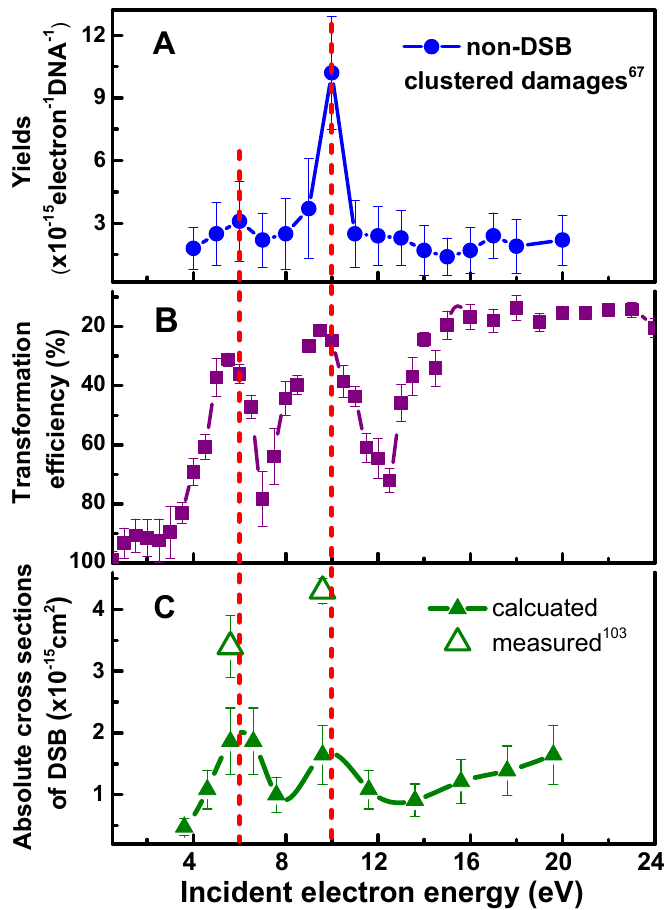
Figure 2. ( A ): Energy dependence of non-DSBs clustered damages [67]. ( B ): Inverted percentage curve that represents the transformation e ffi ciency of E. coli cells. It was produced by irradiating with 0.5–24 eV electrons the pGEM3Zf( − ) plasmid required for survival of the competent cells. ( C ): Absolute cross sections for inducing DSBs by 4–20 eV electron impact on the pGEM3Zf( − ) plasmid [103]. The solid points are calculated from the e ff ective yields with penetration factor f = 0.29 ± 0.14 [86]. Dash lines indicate that the energies of the two prominent peaks around 6 and 10 eV of non-DSB clustered damages correlate well with those of cell